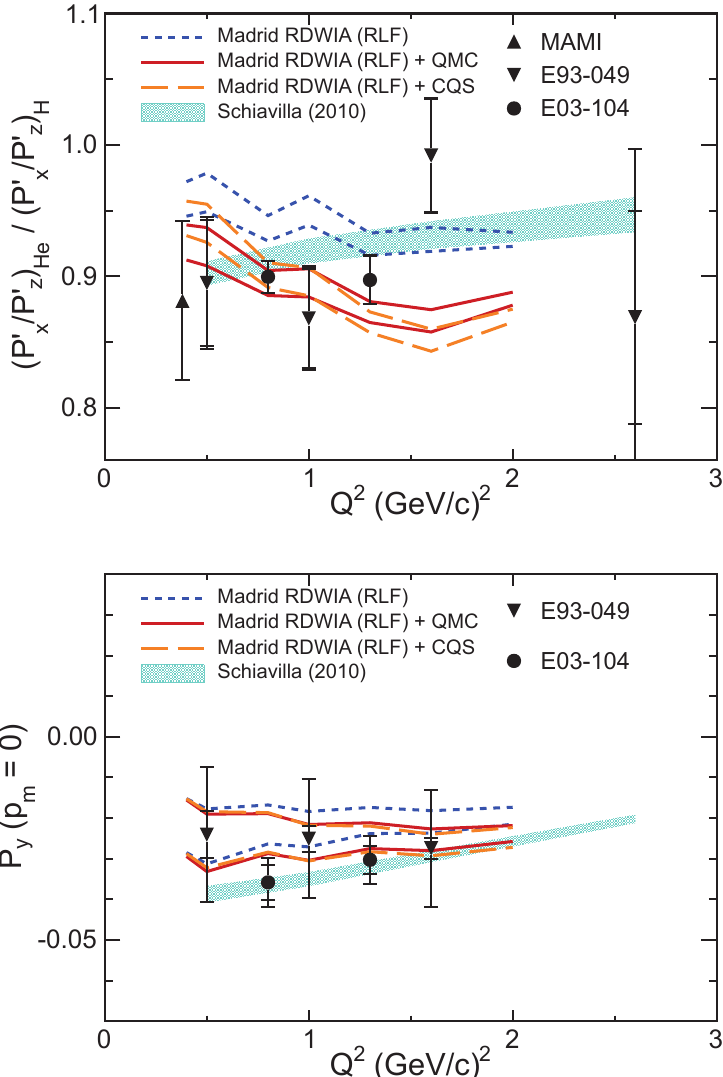
Fig. 3. 4 He( e , e (cid:2) p ) 3 H polarization-transfer double ratio R (upper panel) and induced polarization P y (lower panel) as a function of Q 2 from MAMI, Mainz [24] and Je ff erson Lab E93-049 [25] (open symbols) and E03-104 [26, 27] (filled circles) experiments. The data are compared to calculations from Schiavilla et al. [30] and the Madrid group [31–33] using the cc1 (lower set of curves) and cc2 (upper set of curves) current operators. In-medium form factors from the QMC [5] (solid curve) and CQS [8] (dashed curve) models were used in two of the Madrid calculations. Note that the P y data have been corrected for the spectrometer acceptance and the comparison with models is made for missing momentum p m ≈ 0. Figure taken from